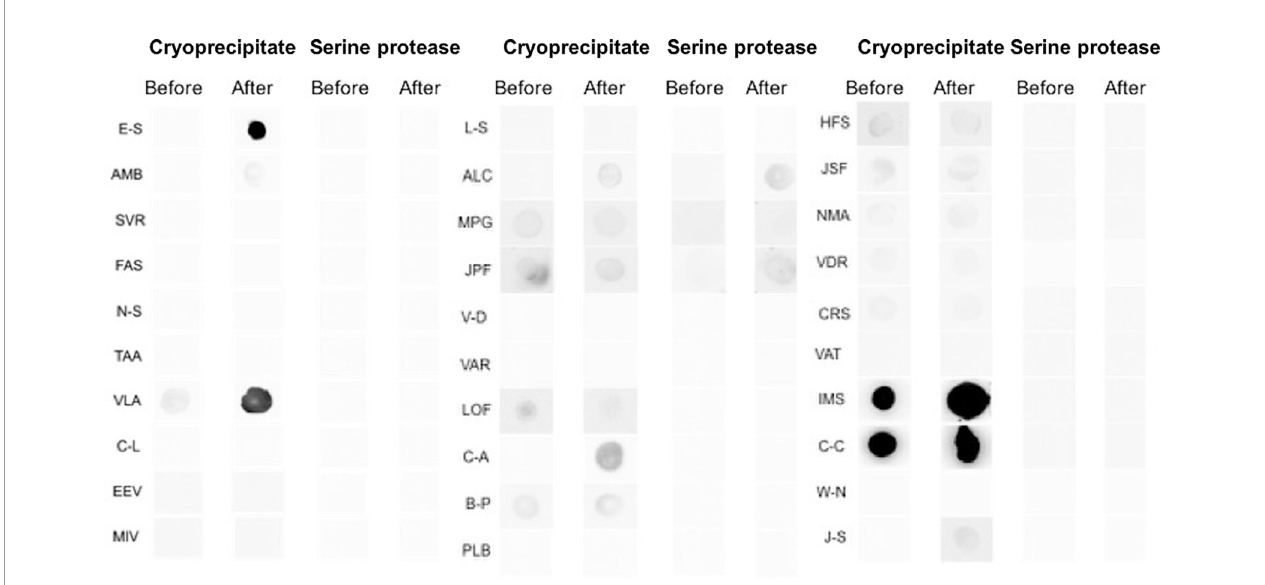
FIGURE 3 | Immunogenicity analysis using the secondary anti-IgE antibody (Abcam) followed by the streptavidin conjugate [HRP] (Abcam) to capture antibodies against cryoprecipitate and serine protease (thrombin like-enzyme) present in the serum of patients treated with heterologous fi brin sealant. The letters (left side of the image) correspond to the initials of the names of the study participants. The data are for 30 participants and not 31, as there was a mislaid of material collected for immunogenicity analysis from all visits by one participant.